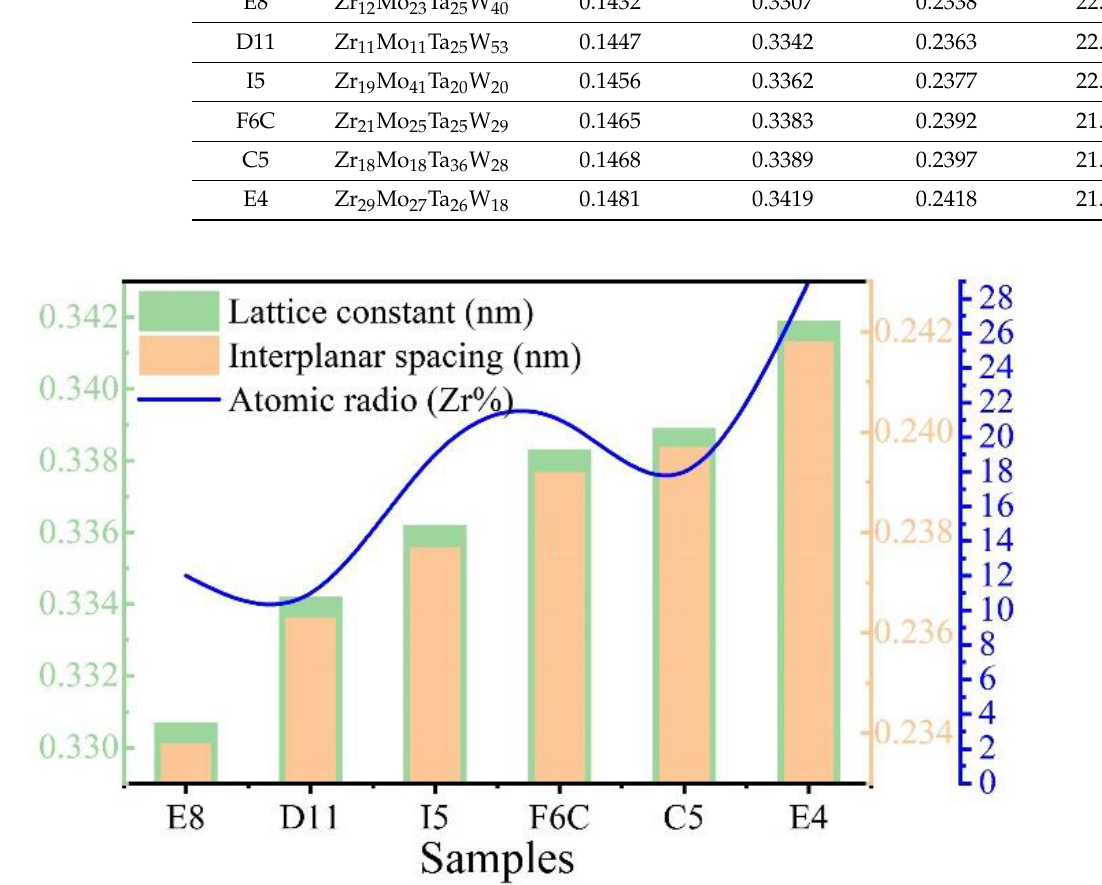
Figure 6. The lattice constant, interplanar spacing, and atomic radio (Zr%) of Zr-Mo-Ta-W RMPEA thin films.